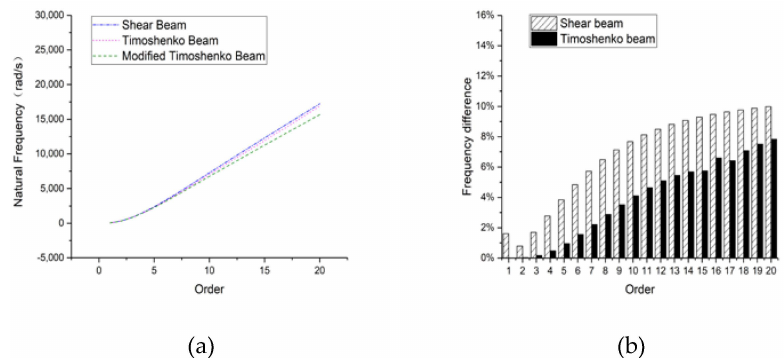
Figure 19. Natural frequencies of the 8-m-long beam: ( a ) overall frequency curve and ( b ) frequency di ff erence compared with a modified Timoshenko beam.